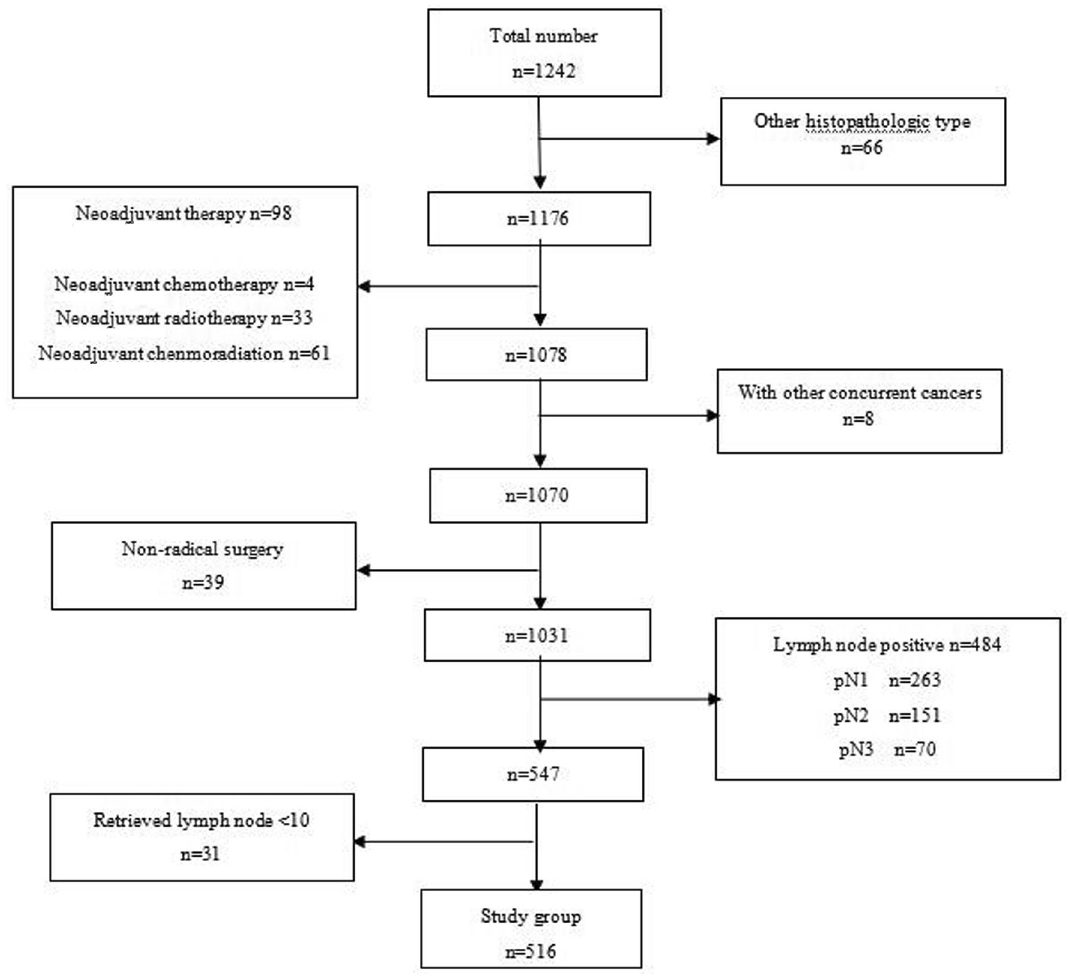
Figure 1. Patients with esophageal cancer underwent surgical resection in the Cancer Hospital of Shantou University Medical College between July 2004 and June